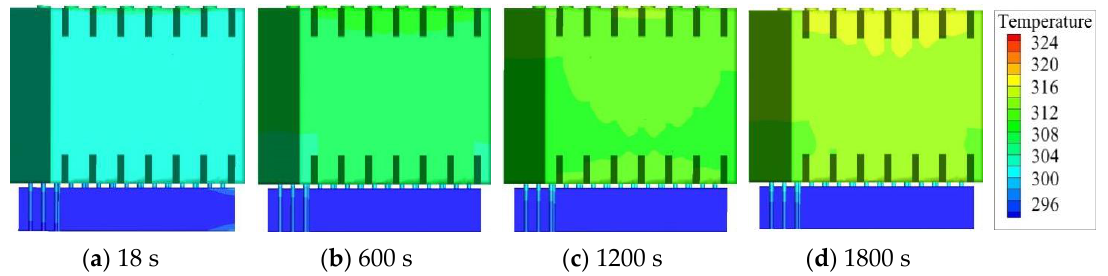
Figure 10. Temperature cloud graphs of battery pack at ambient temperature of 303K.